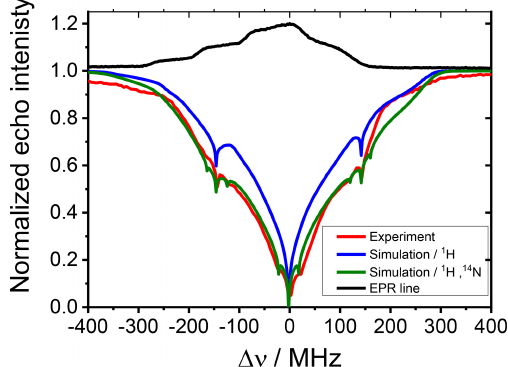
Figure 8. Experimental (red) and simulated (blue and green) EL- DOR spectra of 20mM TEMPOL recorded at the maximum of the EPR spectrum (shown in black). The fit was achieved with (cid:51) eSD = 400µs − 3 , T 1e = 5 . 7ms, T 2 = 100µs. The blue spectra show the re- sult of the simulation including only the 1 H while the green spectra include both 1 H and 14 N SE contributions. The forbidden transi- = 3 × 10 − 3 , A SE = 5 × 10 − 3 and tion fitting parameters were A SE H N = 0 . 4 × 10 − 3 , and the nuclear frequencies were the same as A SE HN